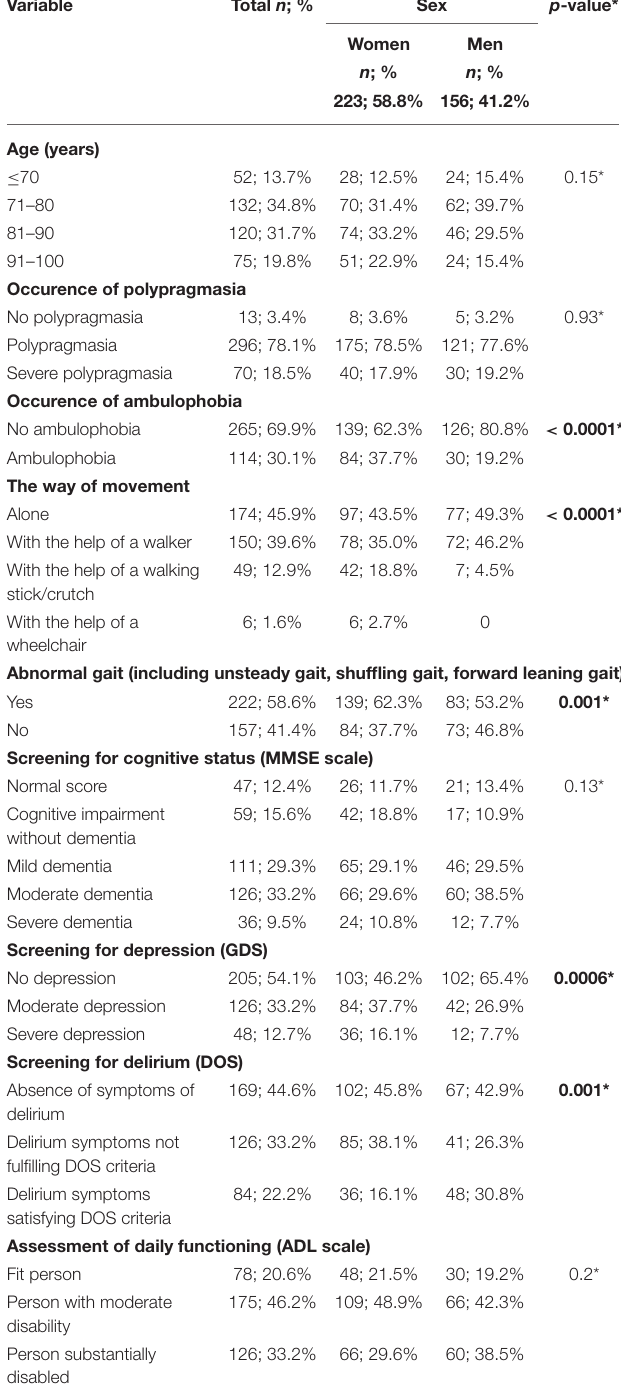
* χ ² test. Bold values indicate statistical